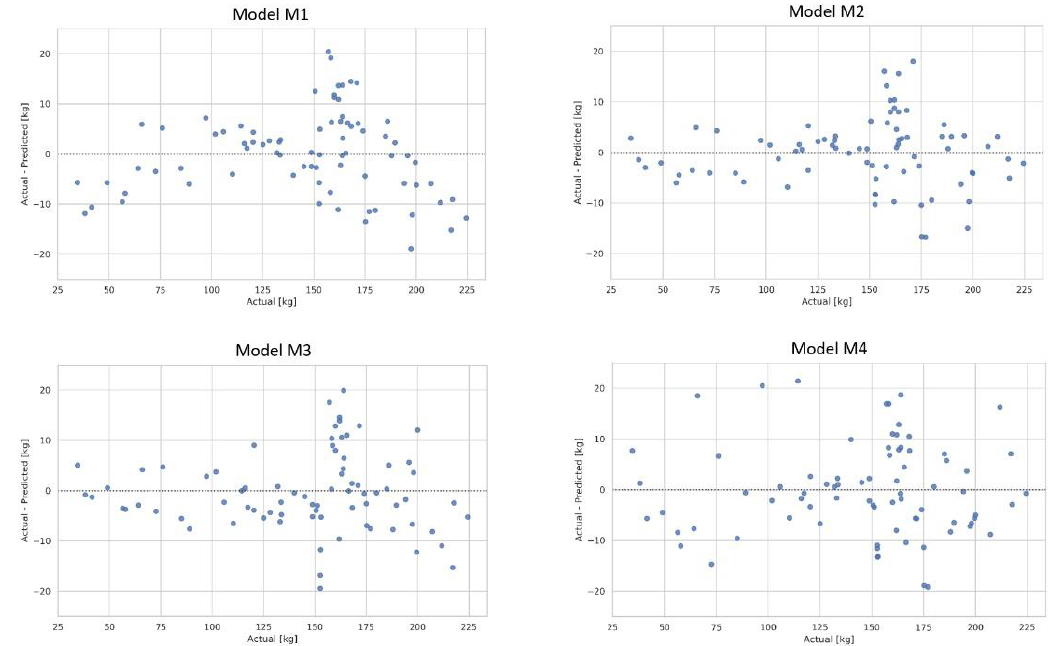
Figure 1. The residual plots of the body weight target feature on testing data fitted to four different models: linear model featuring three traits ( M1 ), quadratic polynomial ( M2 ), linear model featuring a complex trait ( M3 ) and a non-linear model based on the ExtraTreesRegressor algorithm ( M4 ).